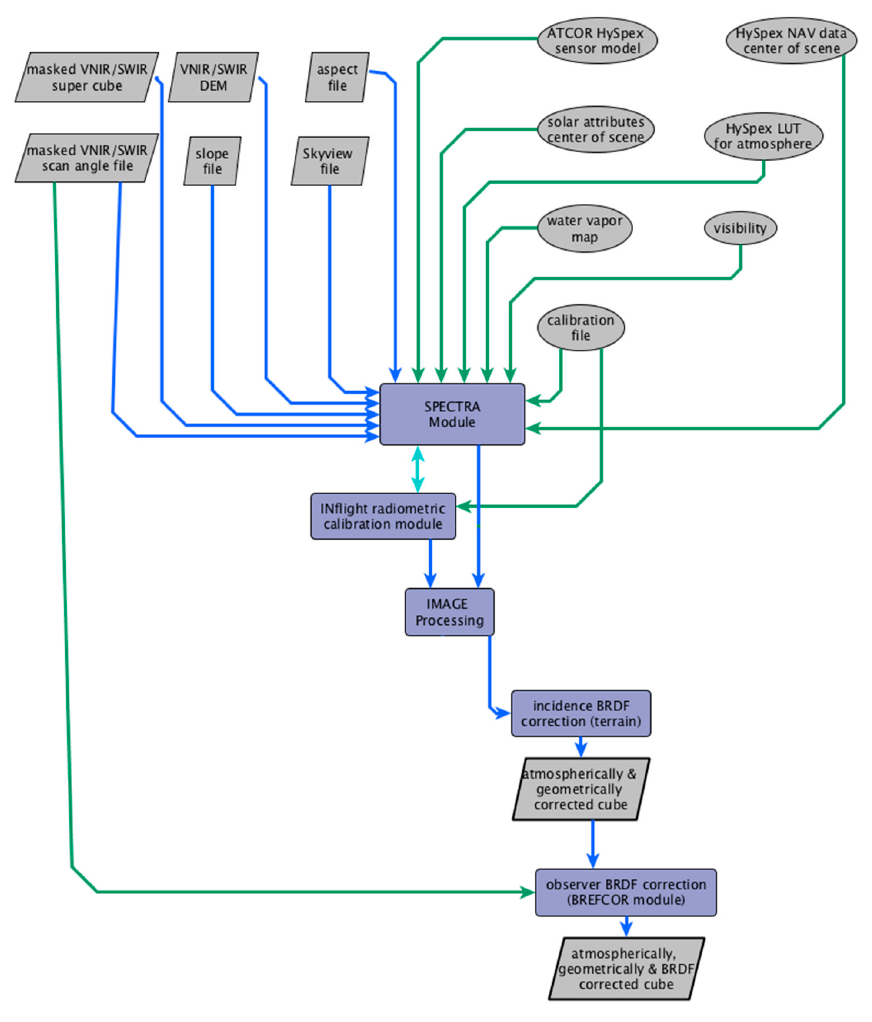
Figure A2. Radiometric correction workflow.